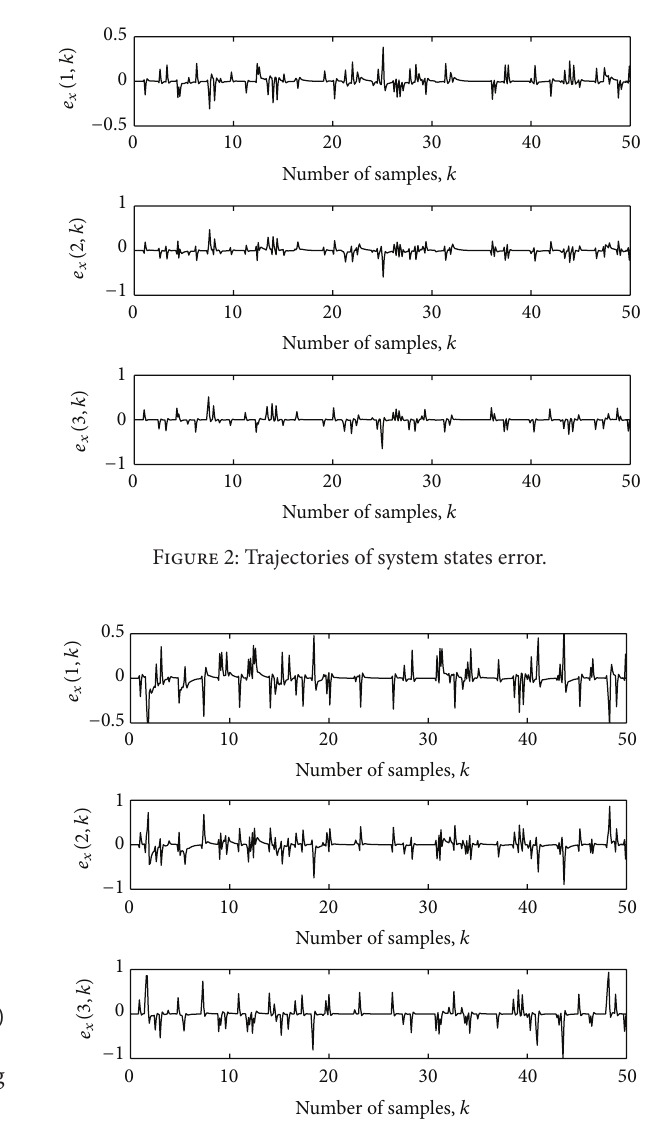
Figure 3: Trajectories of system states error by applying method proposed in